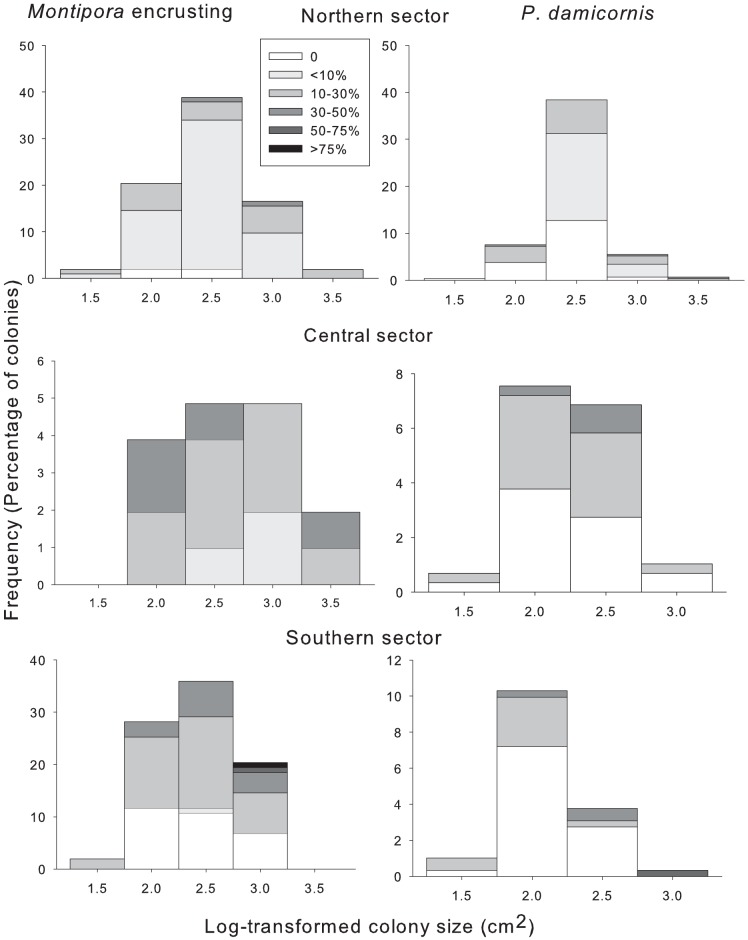
Size-frequency distributions (percentage of colonies) and percentage partial mortality for each size class in each latitudinal sector for encrusting Montipora, and P. damicornis.Size classes were log10 transformed estimates of colony surface area.